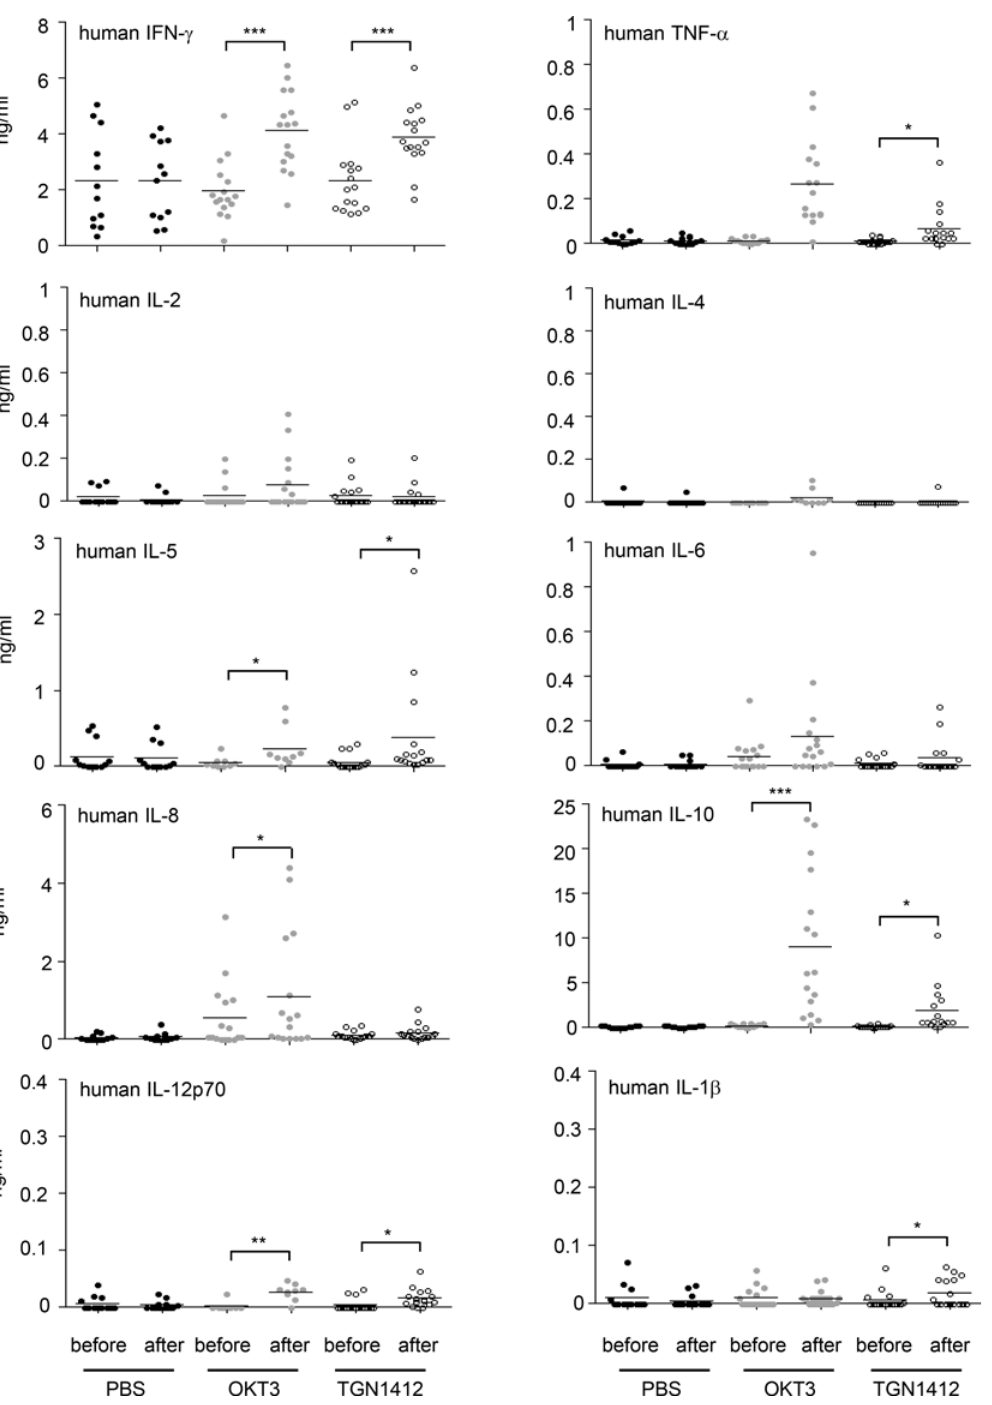
Fig 4. Release of human cytokines in humanized mice upon OKT3 and TGN1412 treatment. Humanized mice were injected i.v. with 20 μ g OKT3 or 20 μ g TGN1412 per 10 gram body weight. As control, humanized mice were injected with PBS. Before and 2 – 6 hours (time point of sacrifice) post OKT3 (n = 16) or TGN1412 (n = 16) application, blood was collected and investigated for human IFN- γ , TNF- α , IL-2, IL-4, IL-5, IL-6, IL-8, IL-10, IL-12p70, and IL-1 β by human FlowCytomix Th1/Th2 11plex analysis. PBS-treated mice (n = 12) were used as control. *** p < 0.001; ** p < 0.01; * p < 0.05 (paired t-test for differences after-before). Data shown are taken from 4 – 6 independent